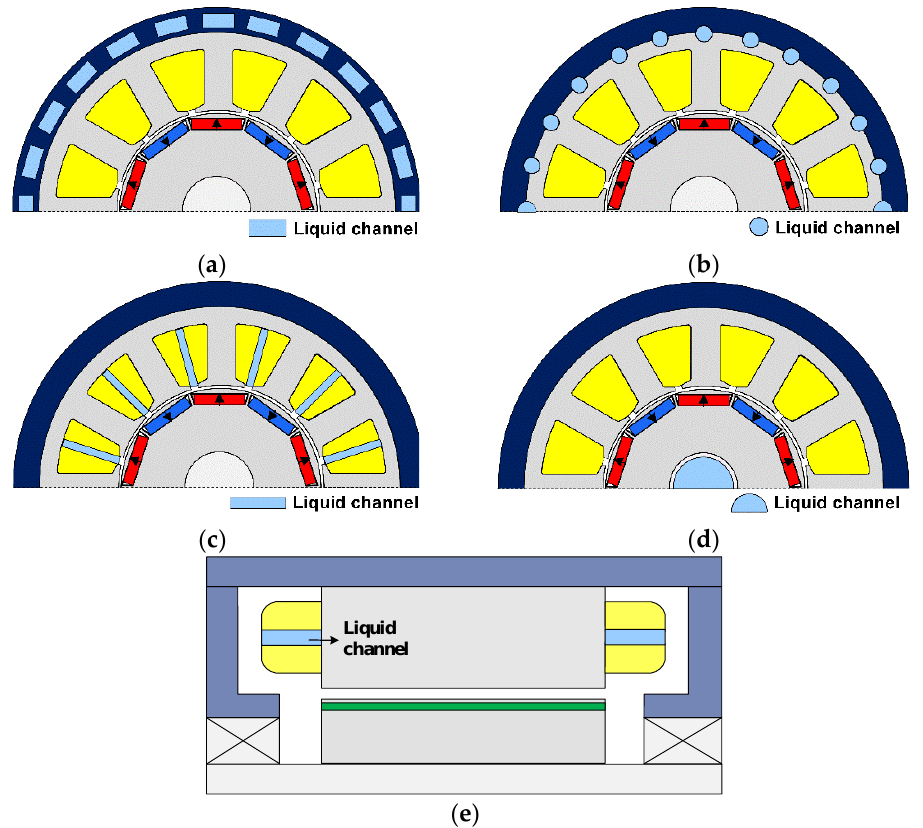
Figure 10. Indirect liquid cooling channels within an IPM machine. ( a ) Frame. ( b ) Stator core. ( c ) Active-winding. ( d ) Shaft. ( e )